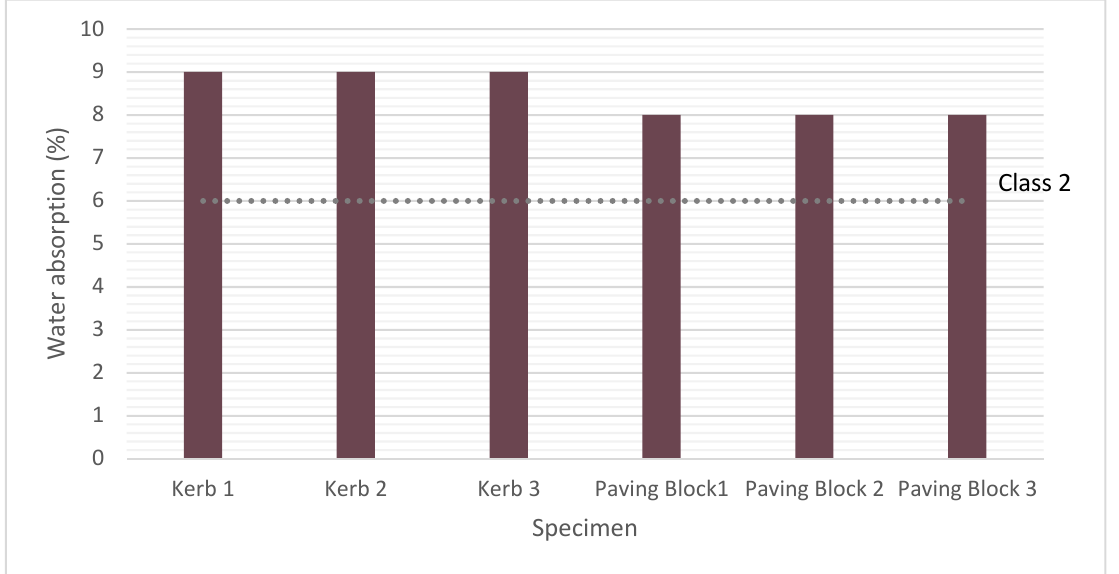
Figure 8. Water absorption test findings for six RACC specimens (three kerbs and three paving blocks) and maxima specified in the respective standards, EN 1340 [46,47] and 1338 [42,43] for class 2/product marking ‘B’ classification.